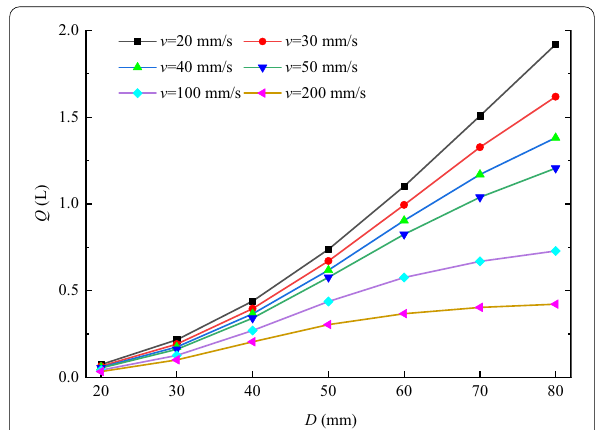
Figure 6 The influence curve of the sampling tube diameter on the coring volume